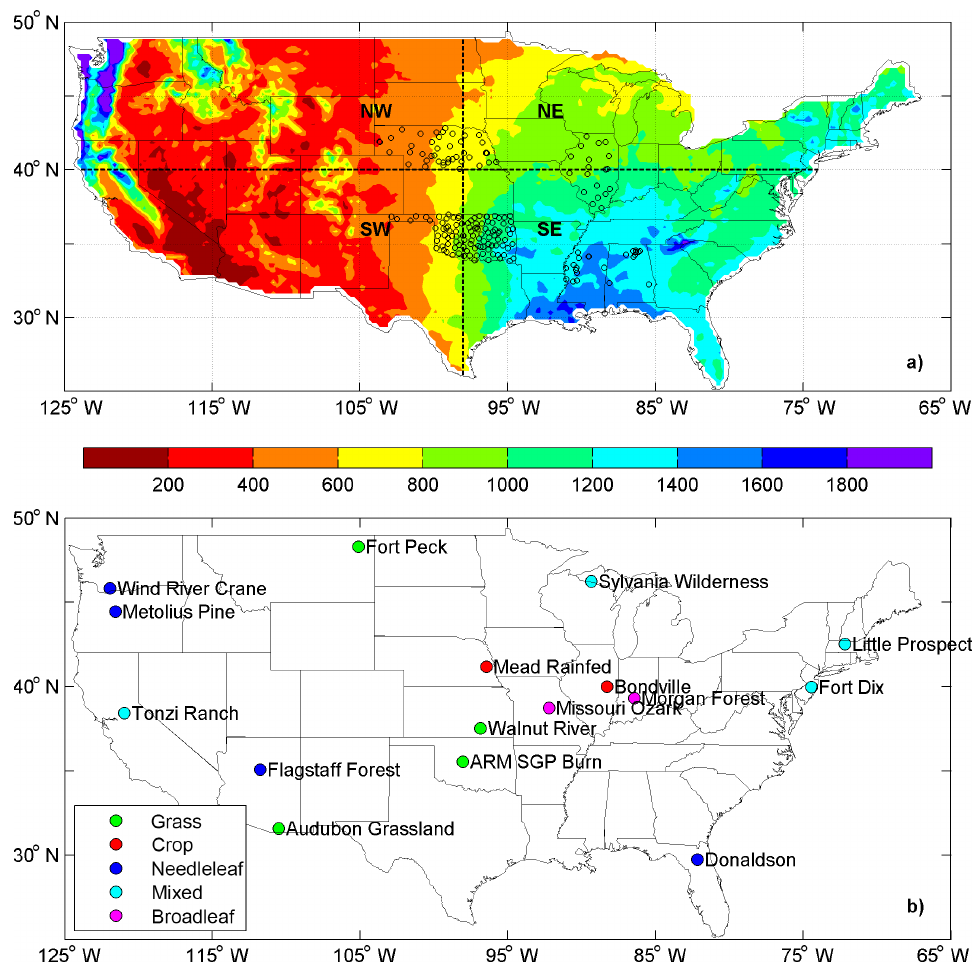
Figure 1. (a) Mean annual (1980–2015) precipitation in millimeters over the conterminous USA (CONUS). NW, SW, NE, and SE rep- resent the Northwest, Southwest, Northeast, and Southeast CONUS, respectively. The black circles represent sites of in situ soil moisture observations in Alabama, Illinois, Mississippi, Nebraska, and Oklahoma. (b) Locations of the 16 AmeriFlux stations with vegetation